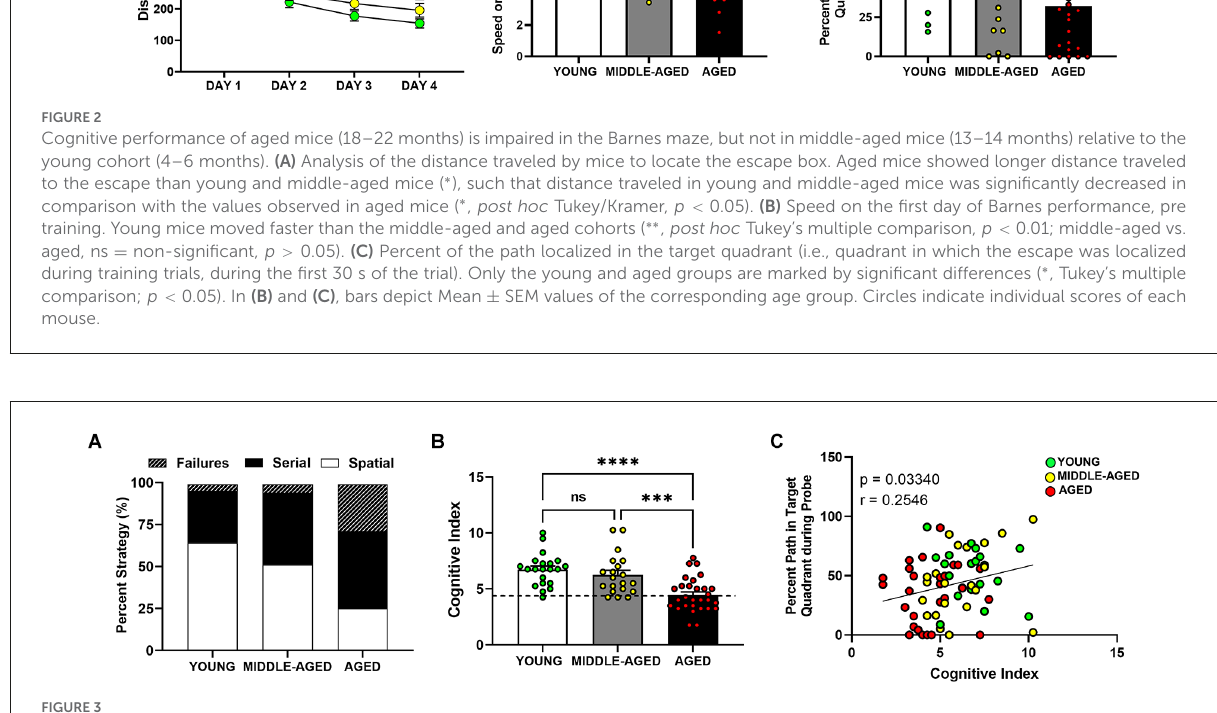
FIGURE3 Aged mice (18–22 months) show lower hippocampal-dependent performance in Barnes maze. (A) Representative between-group comparison of profiles of strategy selection by each age group for entire training session (prior to probe). (B) Summed cognitive index comparison for training trials showed an age effect due to lower use of spatial strategies. Mean ± SEM value of the corresponding age group is shown and dashed line represents the cut off for division between high and low performers (i.e., learning-impaired mice). Young and middle-aged cohorts are not different, but aged mice have significant lower scores (Tukey’s multiple comparison; young vs. aged, ∗∗∗∗ p < 0.0001; middle-aged vs. aged; ∗∗∗ p < 0.001; young vs. middle-aged, ns = non-significant, p > 0.05). (C) Correlation between cognitive index and probe analysis of Barnes performance. Circles indicate individual scores of each mouse and are color coded as in (B) . Cognitive index was positively correlated with the percent path values from the probe trial (Person correlation p <